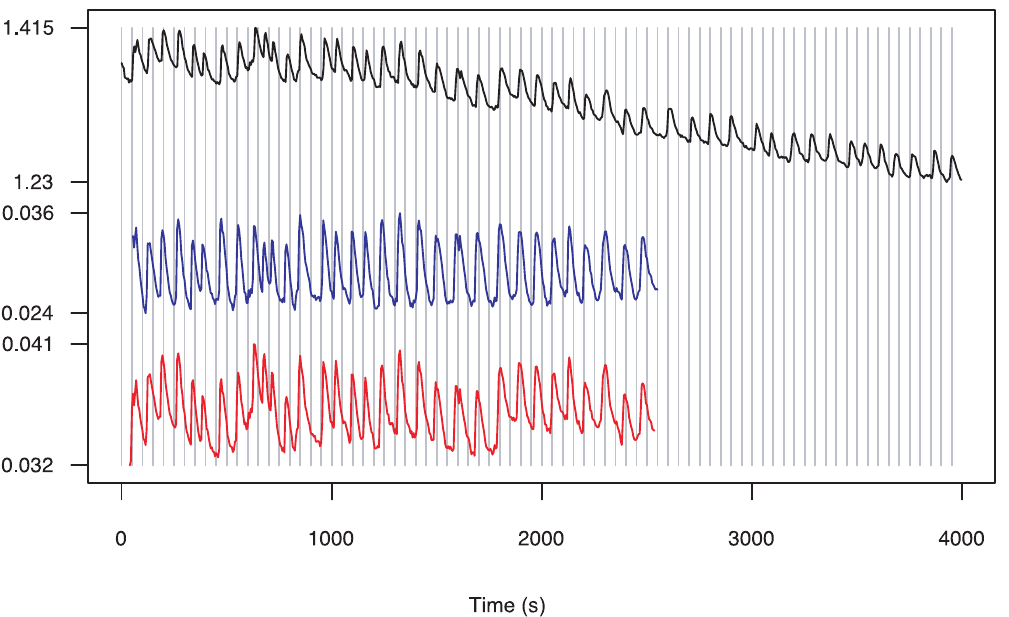
Figure 1. Time series Nod1 given as an example of a raw Nod Factor induced Ca 2 + spiking trace and after detrending using a moving average (blue) and Empirical Mode Decomposition (red). The Y axis is a fluorescence ratio between Ca 2 + sensitive and Ca 2 + insensitive dyes. The X axis is time in seconds.